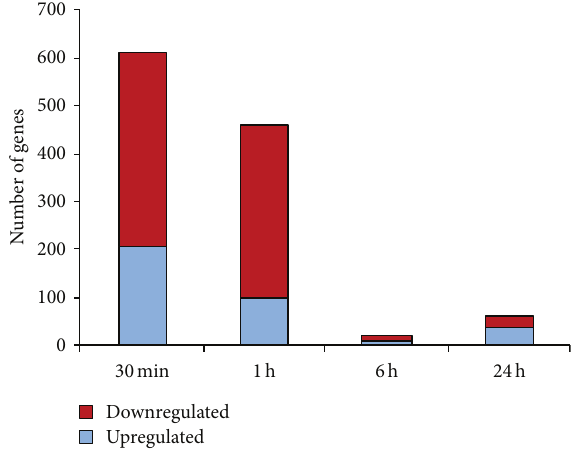
Figure 2: The number of genes in lung myofibroblasts with signif- icant changes in expression at varying time points following Thy1 stimulation. Graphic presentation of GeneChip microarray results obtained from primary myofibroblast RNA extracts following stim- ulation with G7 anti-Thy mAb (5 𝜇 g/mL) or control IgG isotype for 30 min, 1h, 6h, or 24 h. The microarray data were processed by volcano analysis. Upregulated genes (blue), downregulated genes